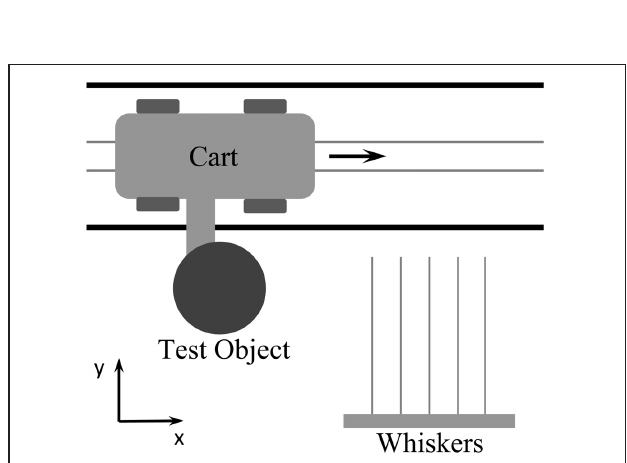
FIGURE 4 | Linear actuation system with test objects and artificial